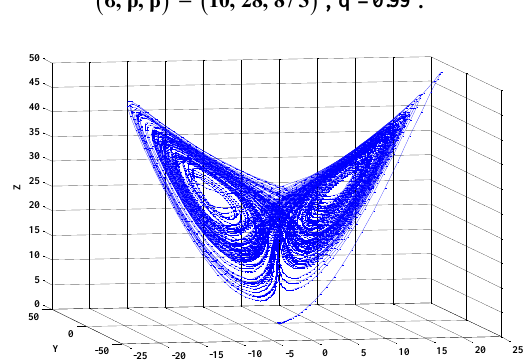
Figure 6. Chaotic behavior of fractional-order Lorenz system with G–L definition of fractional derivatives when   